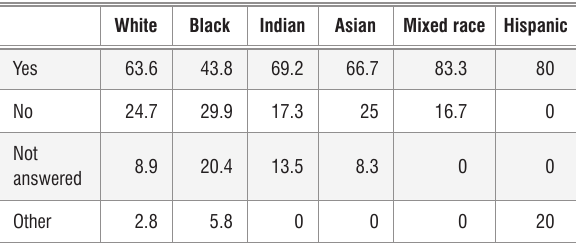
Table 4: Percentage acceptance of human evolution by population